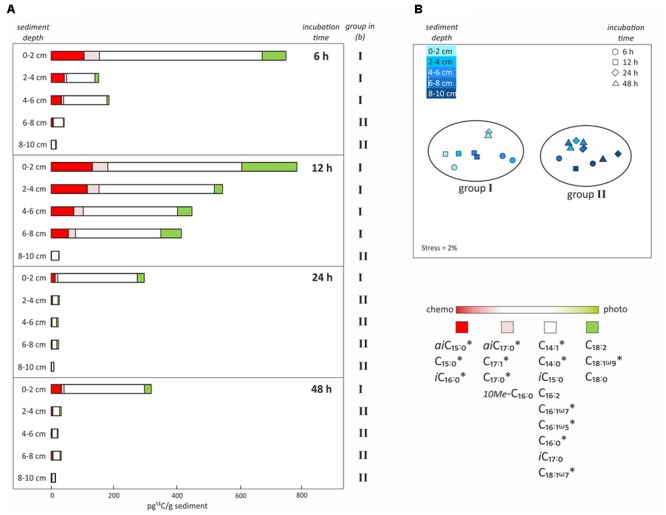
Uptake of 13C-bicarbonate into lipid biomarkers under dark conditions as a function of incubation time and sediment depth. (A) Total uptake of 13C-bicarbonate into different fatty acids after sediment core incubations under dark conditions as a function of time (6, 12, 24, or 48 h) and sediment depth intervals (0–2, 2–4, 4–6, 6–8, or 8–10 cm). Colors reflect the likely source of the fatty acids as inferred from the dark/light ratios of 13C-bicarbonate uptake depicted in Figure 4. (B) Non-metric multidimensional scaling analysis (NMDS) based on total 13C uptake into each fatty acid in all depths and of incubation times, identifying the presence of two groups of samples that are statistically different from each other. ∗Indicates significant negative correlation between fatty acid and sediment depth.